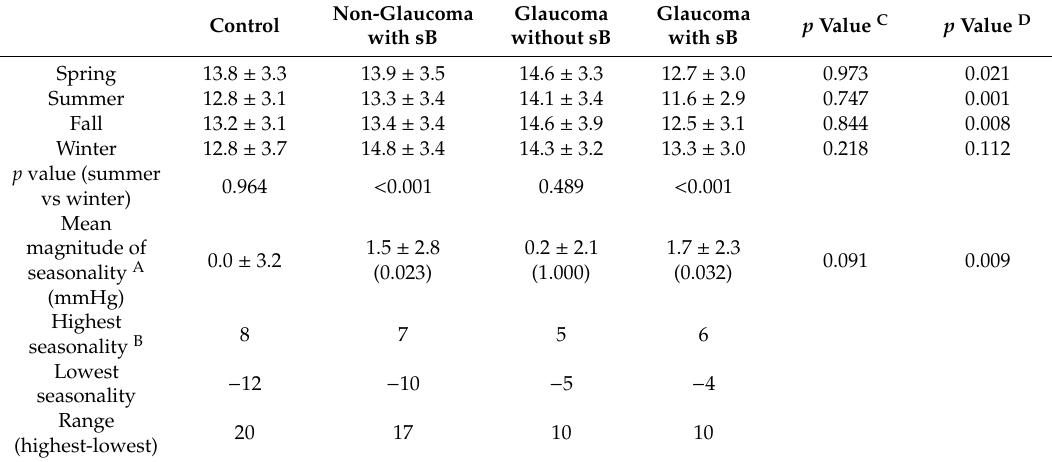
Table 2. Mean intraocular pressure (mmHg) in each season.